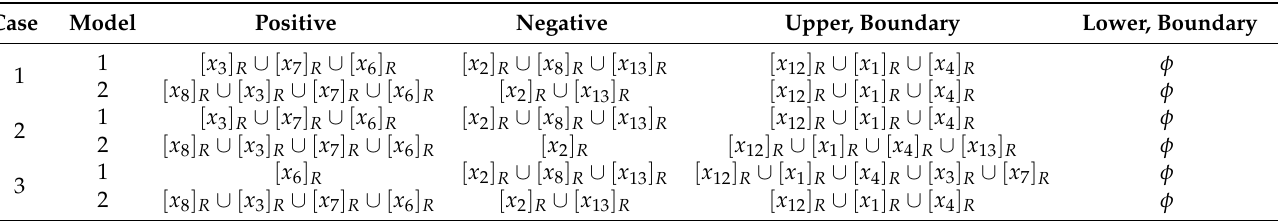
Table 9. The four regions of Models 1 and 2.